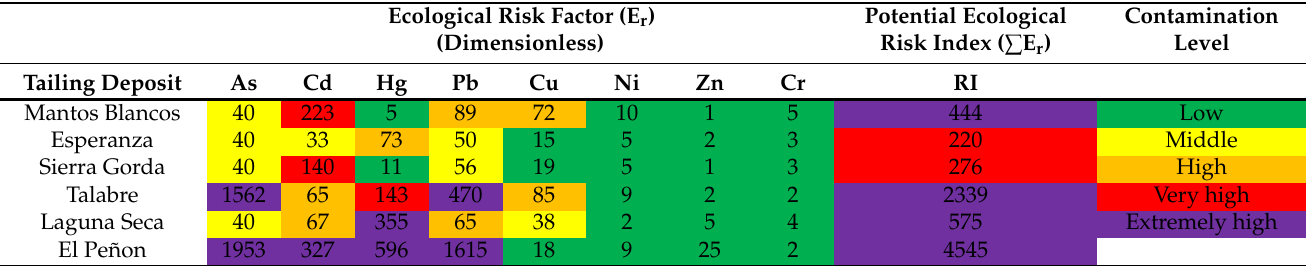
Table 6. Average heavy metal concentration values and potential ecological risk index for tailing deposits of the Antofagasta region (see last column for color